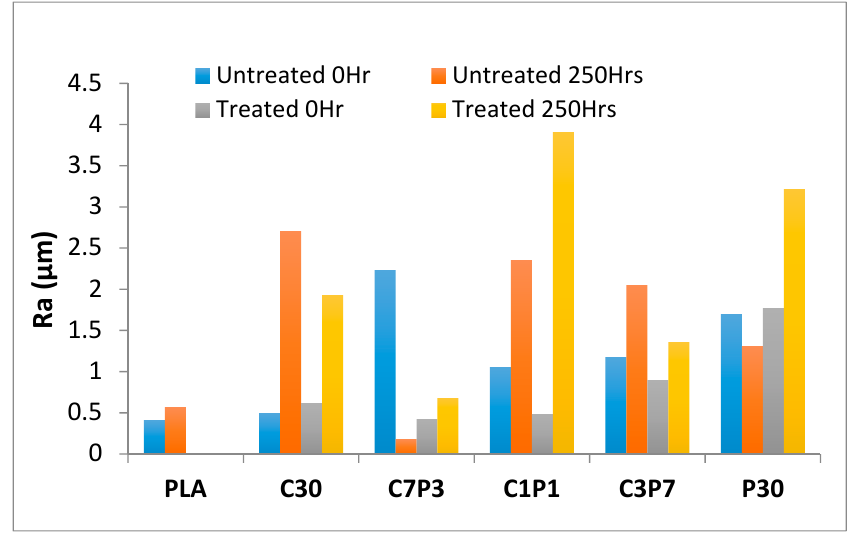
Figure 3. Change in surface roughness parameter Ra over time for PLA and untreated and alkali-treated CF/PALF/PLA biocomposites.